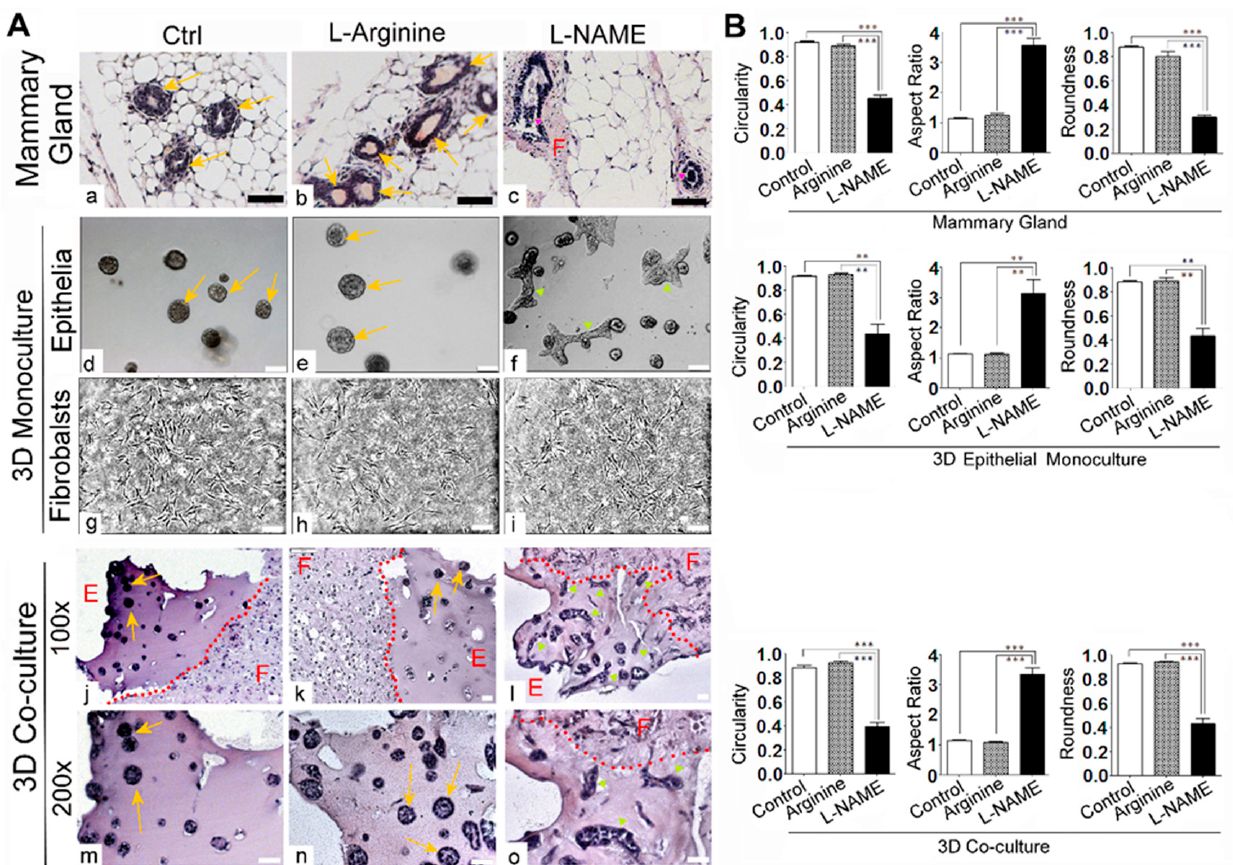
Figure 3. Treatment with nitric oxide synthase inhibitor L-NAME caused the aberrant morphologies of mammary gland epithelia and fibroblasts in vivo as well as in organotypic 3D co-cultures. ( A ) Representative micrographs of drug-treated samples. ( a – c ) Mouse mammary glands treated with control (vehicle), L-arginine (20 mg/kg, nitric oxide synthase agonist) or L-NAME (20 mg/kg, nitric oxide synthase inhibitor) for 6 weeks. Tissues were paraffin-embedded, sectioned and stained with hematoxylin and eosin. Note the formation of multiple intraductal papillomas as well as the expansion of periductal fibroblasts in L-NAME-treated glands. Three-dimensional mono-cultures of MECs ( d – f ) and MFs ( g – i ) treated with the same drugs (control: vehicle, L-arginine (2.5 mM) or L-NAME (2.5 mM)) for 2 weeks. Note the formation of elongated colonies in L-NAME-treated culture. ( j – l ) 100 × magnification images of 3D organotypic co-cultures treated with the same drugs for 1 week (MECs and MFs were also pre-treated with the drugs for 1 week before being placed in co-cultures). Co-cultures were treated with control (vehicle), L-arginine (2.5 mM) or L-NAME (2.5 mM) throughout the whole culturing period. Co-cultures were harvested, paraffin-embedded, sectioned and stained with H&E. Red dotted lines separate MECs (E, glandular epithelial structures) in Matrigel vs. MFs (F, connective tissues) in collagen/Matrigel matrix. ( m – o ) 200 × magnification images of co-cultures. Note the elongated structures of MEC colonies and the irregular shapes and orientation of MFs in L-NAME-treated sample. Arrows: mammary acini; pink arrowheads: intraductal papillomas of mammary glands; yellow arrowheads: elongated 3D colonies. Scale bars: 50 µ m. ( B ) Quantification of shape descriptors (Circularity, Aspect Ratio and Roundness) of epithelia in micrographs of ( A ) Top row: mammary glands. Middle row: 3D mono-cultures. Bottom row: 3D co-cultures. Circularity = 4 π *area/perimeter^2. Aspect Ratio = major_axis/minor_axis. Roundness = 4*area/( π *major_axis^2). Data are presented as the arithmetic mean ± SEM. ** p < 0.01; and *** p < 0.001.